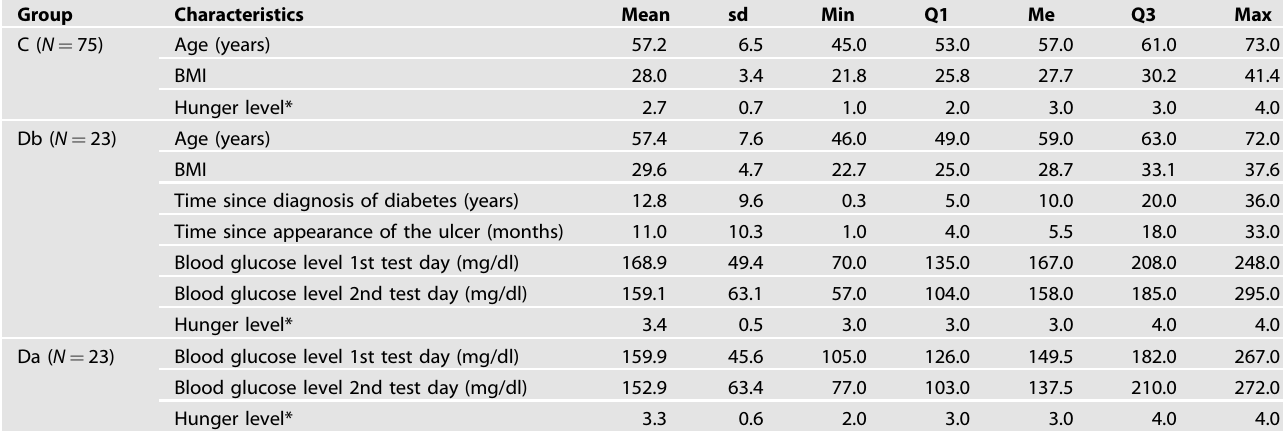
Table 1. Characteristics of Control Group (C) and patients with diabetic mellitus with diabetic foot ulcers before (Db) and after (Da) hyperbaric oxygen therapy.